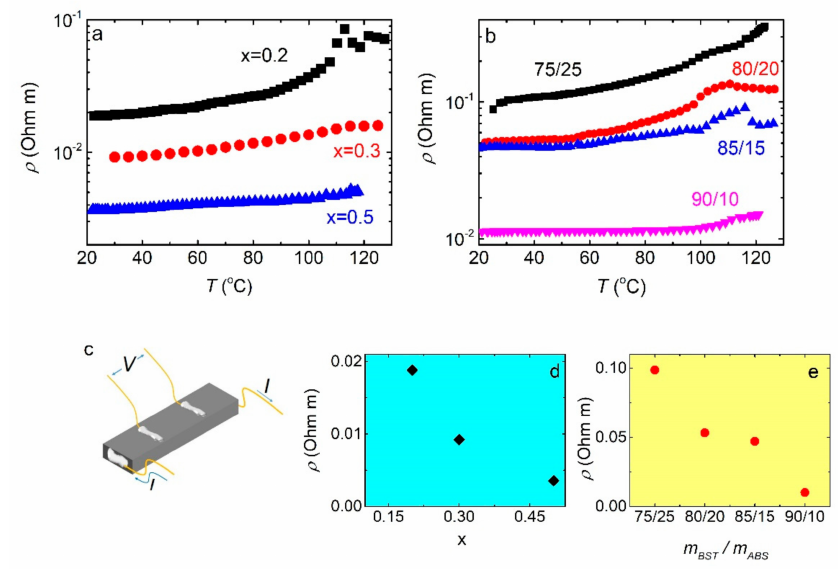
(cid:16) (cid:17) m BST = 80 for various Bi dopings. m ABS 20